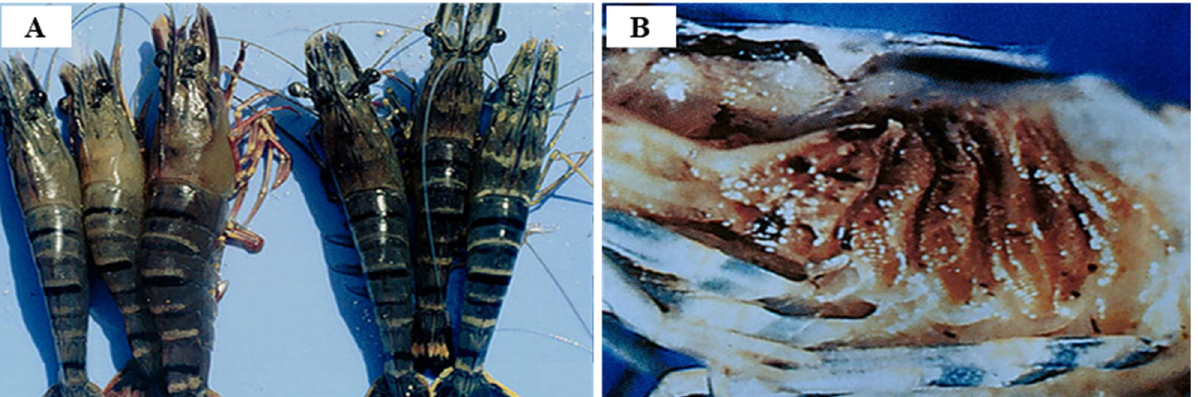
Figure 16. External symptoms on yellow head virus genotype 1 (YHV genotype 1)-infected shrimp. ( A ) P. monodon showing signs of yellow head disease (YHD) Yellow (light gray in print version) to yellow-brown (dark gray in print version) discoloration of the cephalothorax. Three shrimp with (left) and without (right) YHD; ( B ) discoloration of the gill region. (( A , B ) Reprinted from Elsevier Books, Samocha, Sustainable biofloc systems for marine shrimp, p. 23, Copyright (2019), with per- mission from Elsevier).